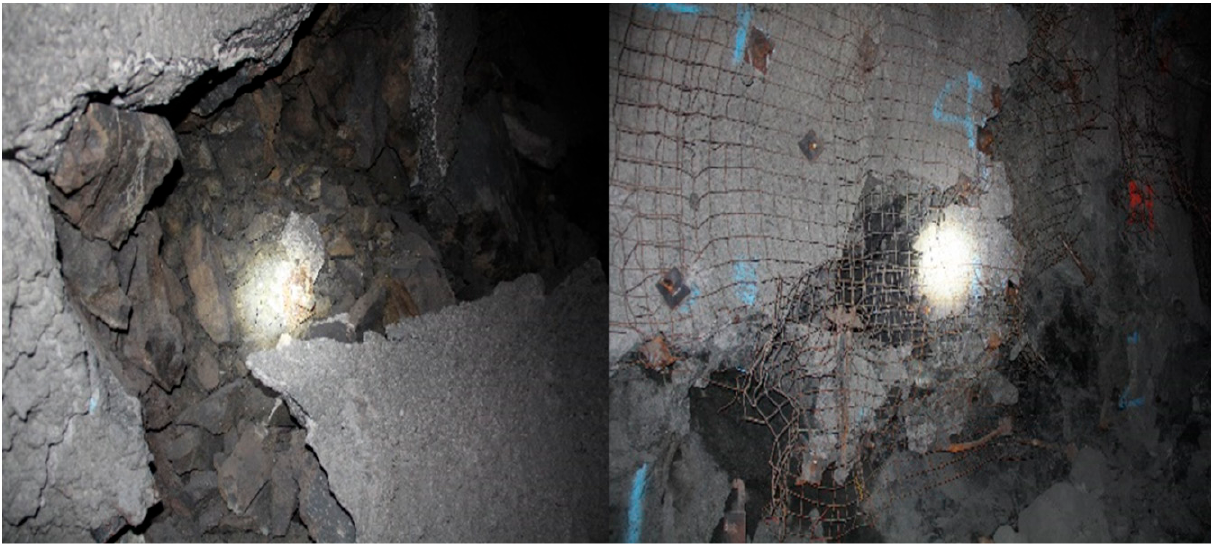
Figure 10. Failure cases near the stope access.